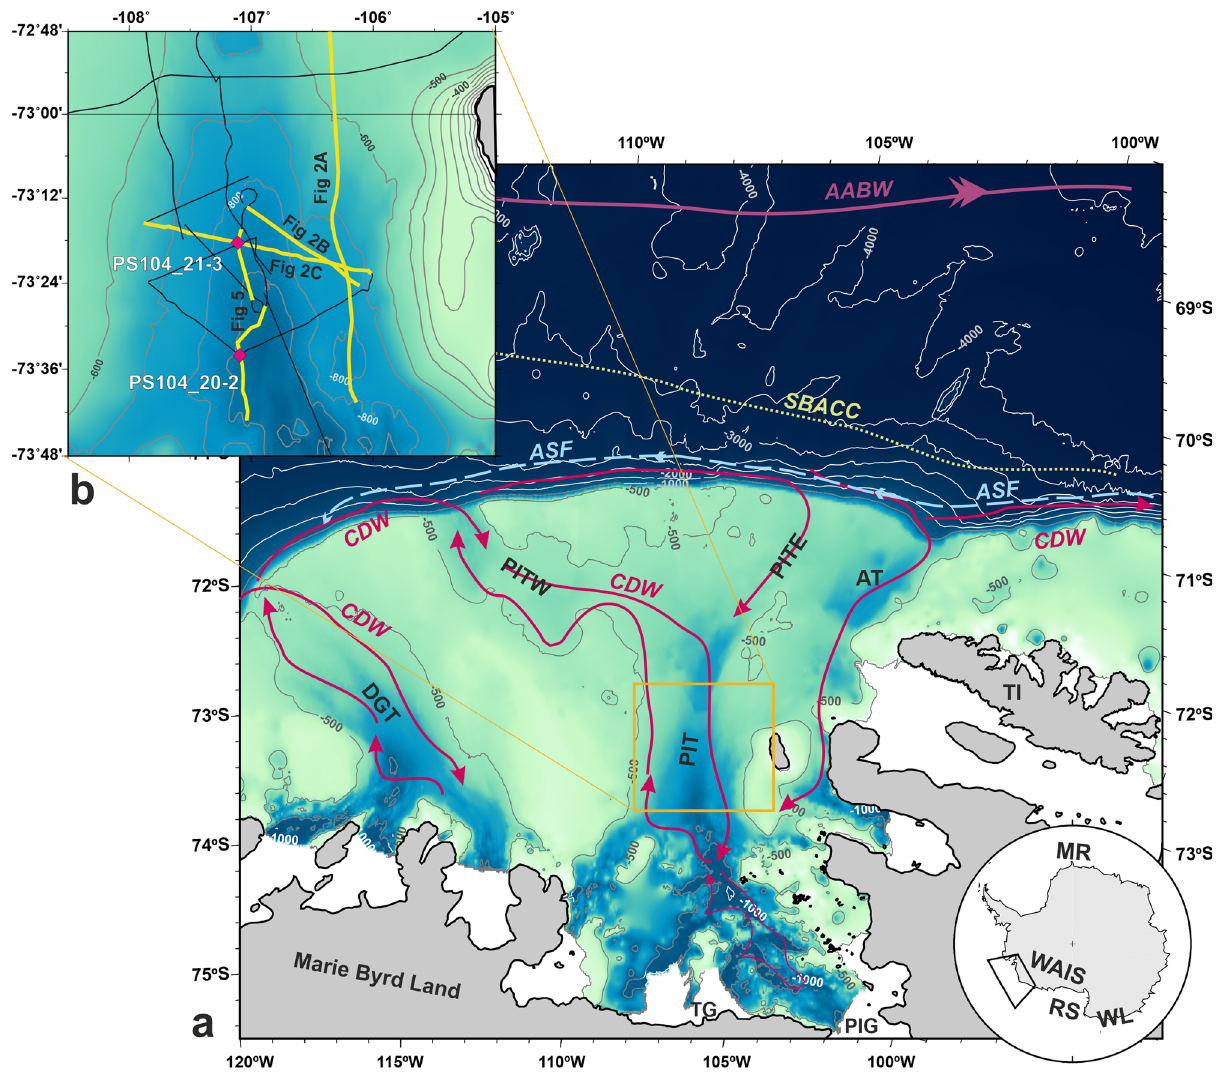
Fig. 1 Bathymetric map of the Amundsen Sea Embayment 78 . a The present day active currents and water masses are shown schematically: AABW = Antarctic Bottomwater (purple double arrow) 79 , SBACC = Southern Boundary of the Antarctic Circumpolar Current (yellow dotted) 60 , ASF = Antarctic Slope Front (dashed light blue arrow) and CDW = Circumpolar Deepwater (red arrow) 3,4,80,81 . The orange box shows the area enlarged in ( b ). There, the locations of seabed drill Sites PS104_20-2 and PS104_21-3 (magenta diamonds) and seismic pro fi les (black lines, yellow lines displayed in Figs. 2 and 5) are shown. AT = Abbot Trough, DGT = Dotson-Getz Trough, MR = Maud Rise, PIG = Pine Island Glacier, PIT = Pine Island Trough, PITE = Pine Island Trough East, PITW = Pine Island Trough West, RS = Ross Sea, TG = Thwaites Glacier, TI = Thurston Island, WAIS = West Antarctic Ice Sheet, WL = Wilkes